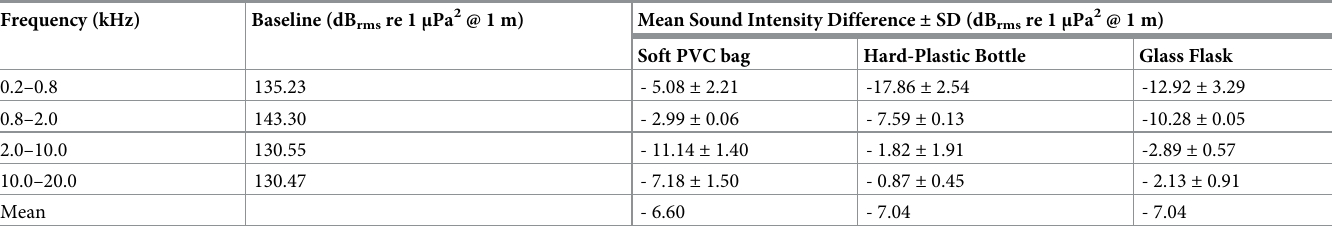
Table 1. Sound transmission loss in three different culture vessels at four different audible spectrum frequency bands. Frequency